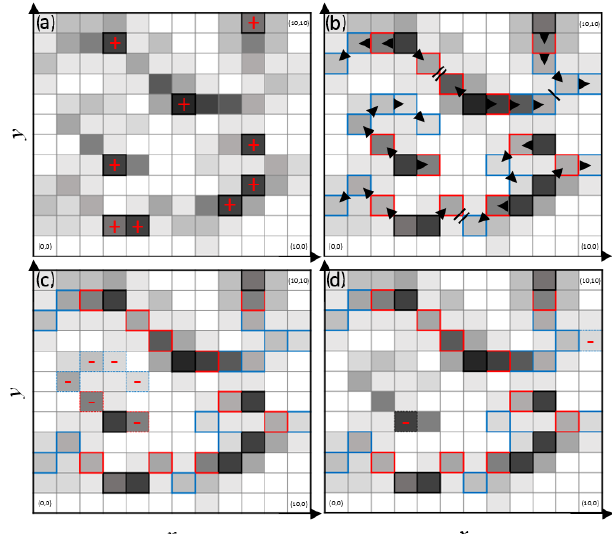
Figure 4. Schematic example of the scarp detection process through maximum slope routing. Panel (a) shows two steps. Step 4.1: determination of the search space Ss ∗ (greyed cells, darker with arbitrary slope). Step 4.2: determination of local maxima Sc 1 (black outlines with a plus sign). (b) Step 4.3: determination of Sc 2 cells (red outlines). Step 4.4: determination of Sc n cells, n > 2 (blue outlines). (c) Step 4.5: elimination of cells where max(ZK 9 ) < 0 . 85 × q 75 (dashed outlines with a minus sign). (d) Step 4.6: elim- ination of isolated cells (dashed outlines with a minus sign). The arrows represent the progressive selection of scarp